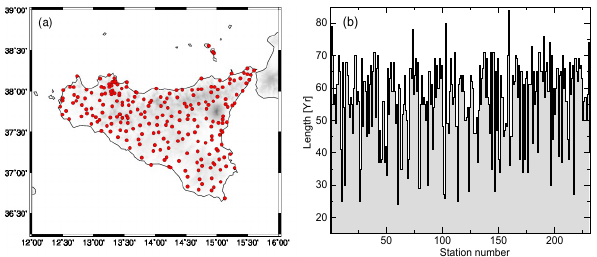
Figure 1. (a) Location of station sites. (b) Number of years with at least 90% of valid data per station